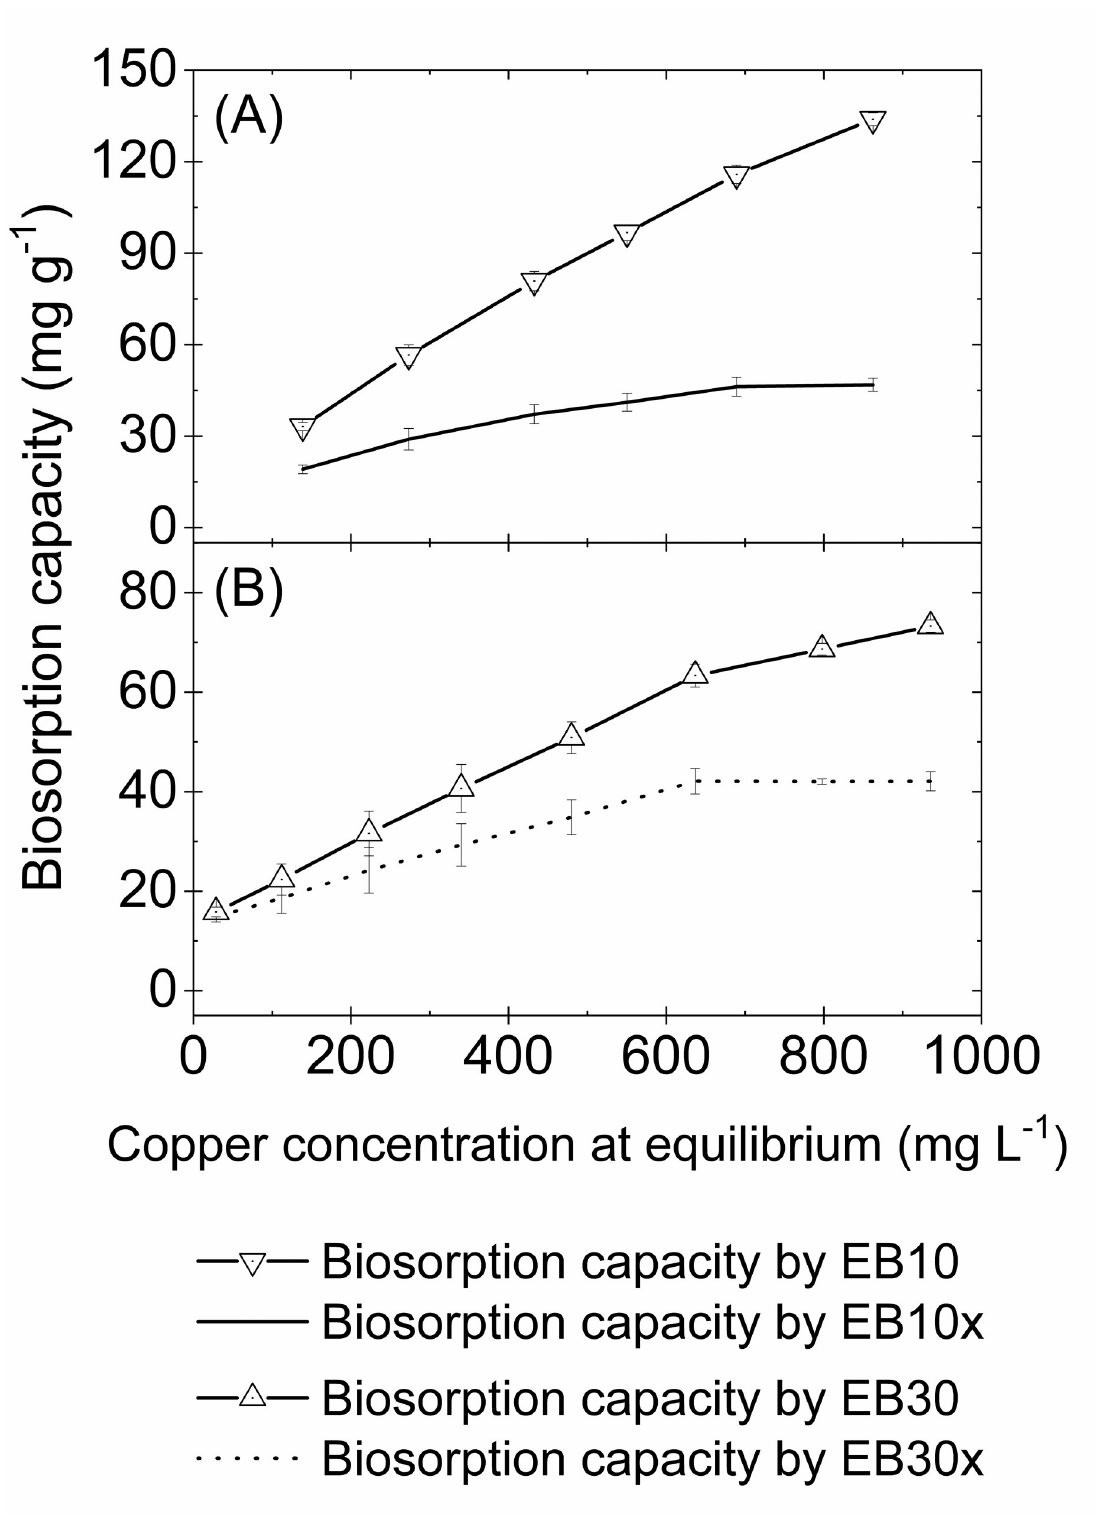
Fig 4. Biosorption capacity of copper by EB10 and EB10x (A) and EB30 and EB30x (B). Conditions: Initial copper concentrations ranging from about 50 to 1050 mg L -1 ; contact time = 240 min; pH = 5.0; agitation speed = 150 rpm; temperature = 25 ± 2˚C; biosorbent dosage for EB10 = 0.333 g L -1 and for EB30 = 1.0 g L -1